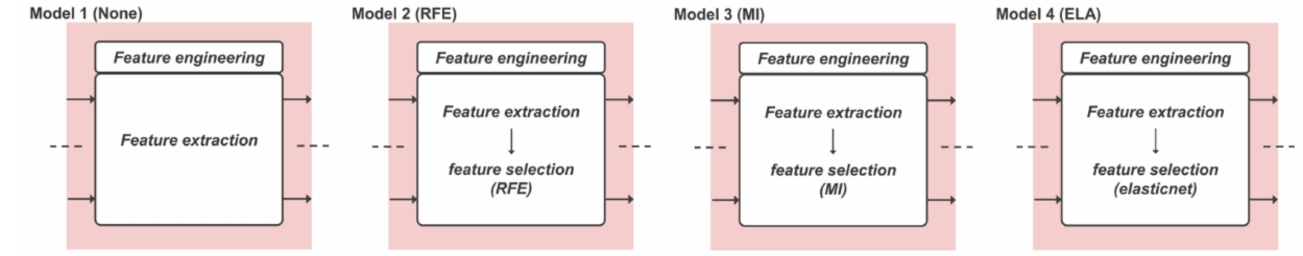
Figure 8. The feature engineering sequence of comparative models is different from the Proposed